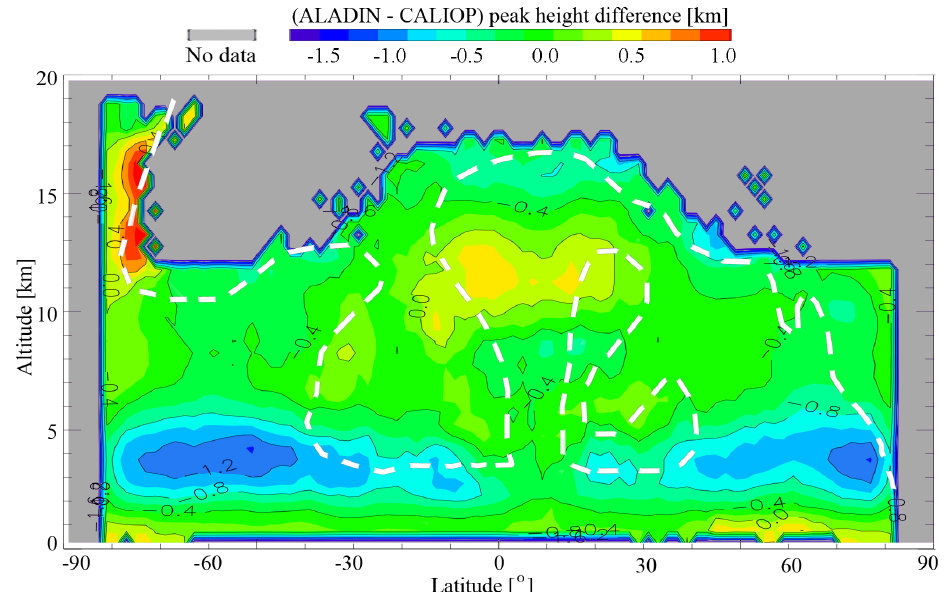
Figure 10. Cloud altitude detection sensitivity represented as a height difference between the CALIOP local peak height and corresponding ALADIN’s cloud peak height or maximal SR height found in the ± 3km vertical vicinity of CALIPSO peak. The subset corresponding to YES_YES selection (Fig. 9a) was used. Dashed white isoline corresponds to colored area in Fig. 9a (occurrence frequency of about 5% or